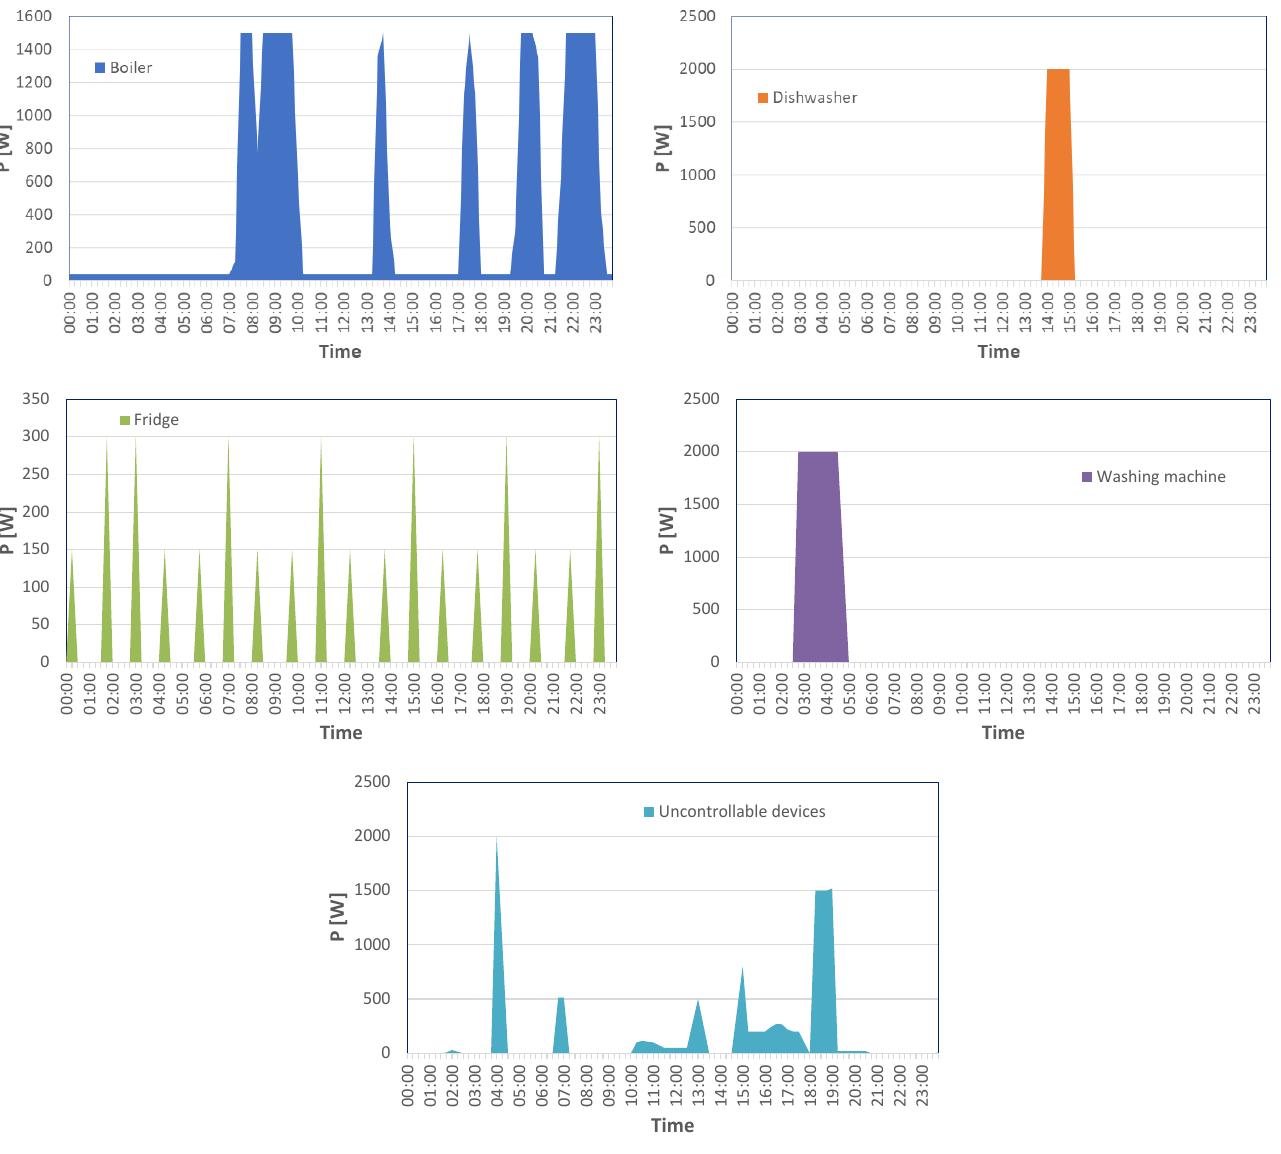
Figure 6. Residential users’ disaggregated power profile.